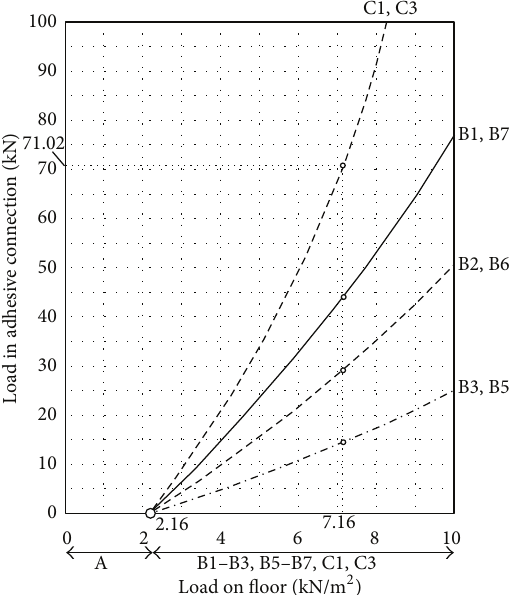
Figure 8: Anchor stress. 𝐿 = 15 m. 𝐻 = 𝐿/30 . 𝛼 0 = 26.57 ∘ .